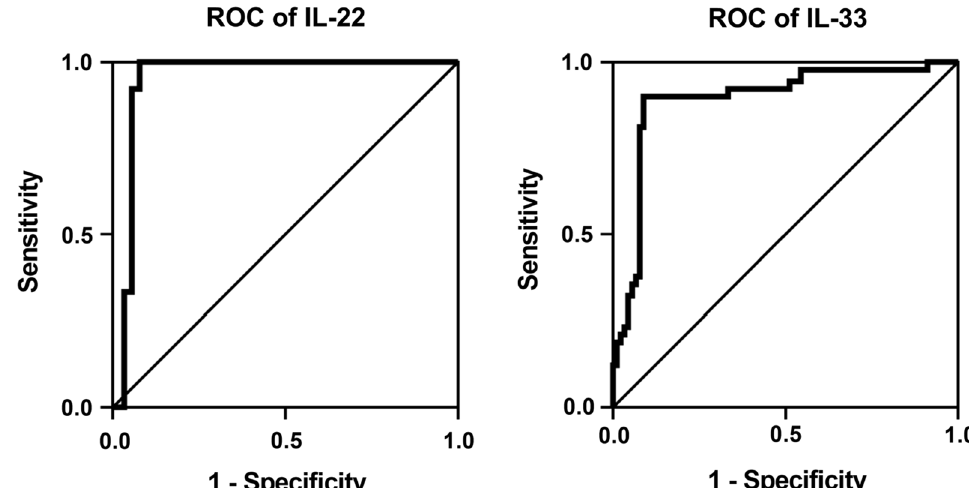
Fig. 3 Reciever operating characteristic (ROC) curve analysis of IL-22 and IL-33 in COVID-19 cases versus healthy controls. IL-22 (area under the curve [AUC] 0.95; 95% confidence interval [CI] 0.908–0.992; p < 0.001; cut-off point = = specificity 92.2%) and IL-33 (AUC 0.892; 95% CI 0.839–0.945; p < 0.001; cut-off point = = = specificity 90.0%) showed excellent prognostic value in differentiating patients from controls. The AUC is estimated through ROC analysis to = describe the overall performance of a biomarker (i.e. cytokine serum level) to discriminate between cases with and without the disease under